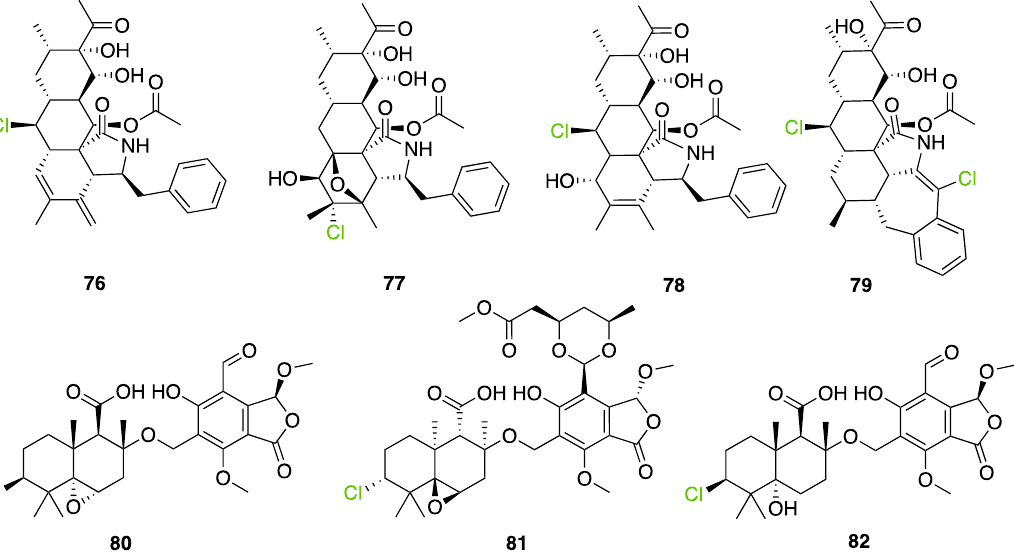
Figure 32. Compounds belonging to cluster 8: curtachalasin derivatives L ( 76 ), I ( 77 ), and K ( 78 ) and xylarichalasin A ( 79 ); and cluster 9: pestalotiopens A ( 80 ), B ( 81 ), and C ( 82 ). Molecules 2022 , 27 , x FOR PEER REVIEW